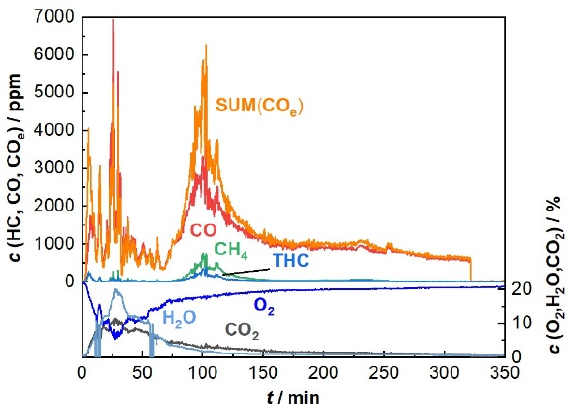
Figure 5. Typical emissions during charge combustion of a wood-log-fueled fireplace (HKD7, Brunner) measured by FTIR (only the main components such as CO, C 2 H 4 , CH 4 and other hydrocarbons; THC plus CO 2 and H 2 O are displayed). The ROC is logged using a commercial lambda probe (LSU 4.9, Bosch) and SUM(CO e ) was calculated according to Equation (1). Here, one can see the difference between the course of c (CO) and that of SUM(CO e ), which occurs if one considers the other main components, CH 4 ( z CH4 = 0,5), THC and C 2 H 4 ( z C2H4 = 13), whereby these fractions contribute by their special weighting factors (Equation (1)). Generally, CO has the main influence on the sensor signal. THC represents the “total hydrocarbons” as a typical FTIR measured value. For the sum evaluation, we chose to consider a mean value as weighting factor ( z THC = 5), which was determined using the values from the lab measurements. The SUM(CO e )-value was corrected by the secondary signal from the lambda sensor as well with its corresponding weighting factor wt(O 2 ) over time. Many other components were determined by FTIR, but they occurred only in low sum signal.